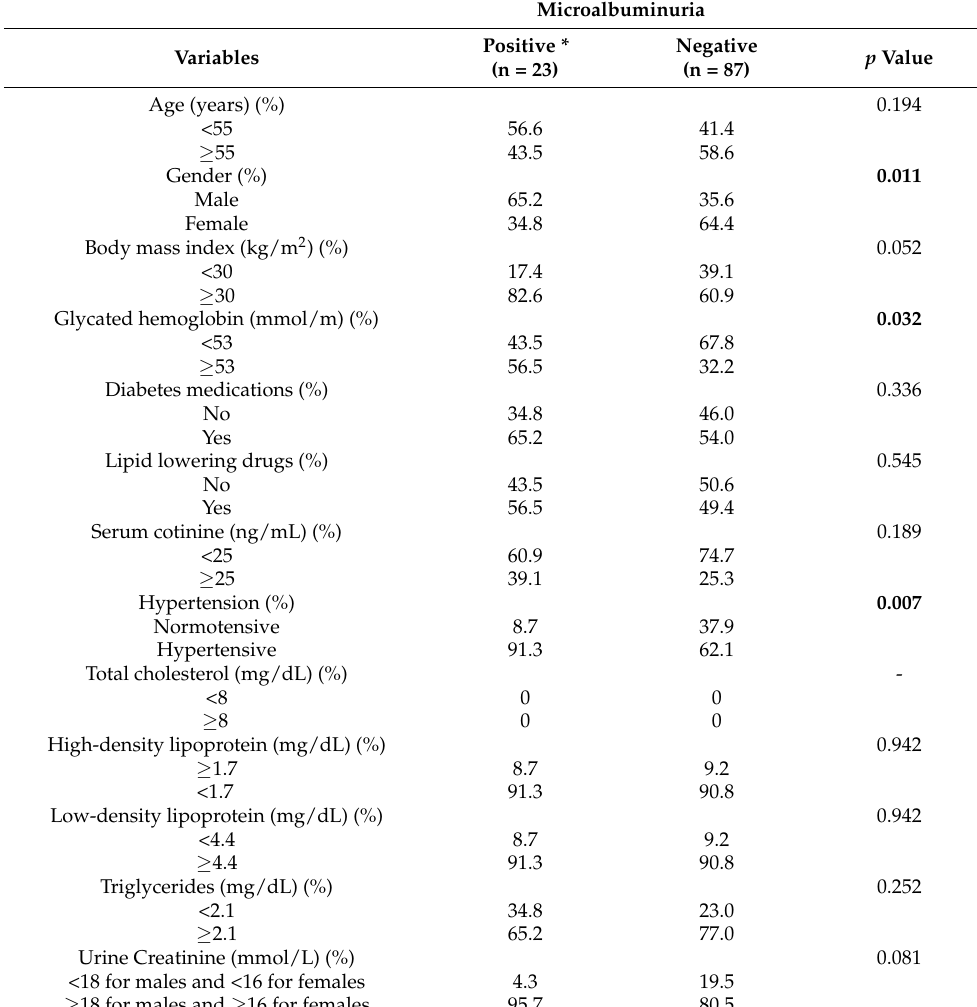
Table 1. Percentages of participants, classified by microalbuminuria and related other characteristics for Turkish immigrants with type 2 diabetes in The Hague, Netherlands, 2011.